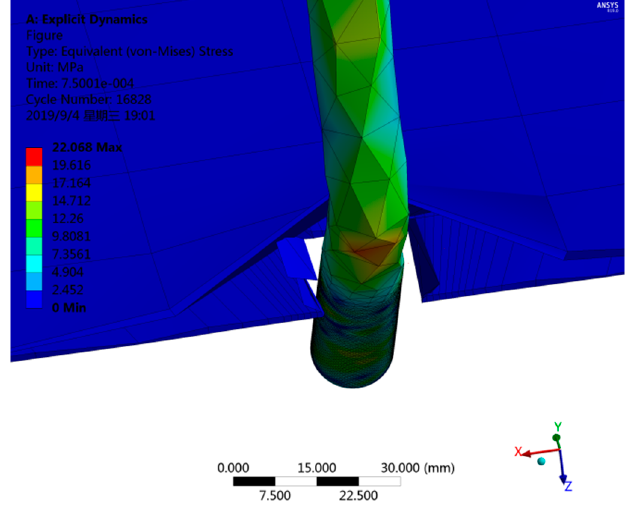
Figure 10. The total stress to bear of the film-picking mechanism.